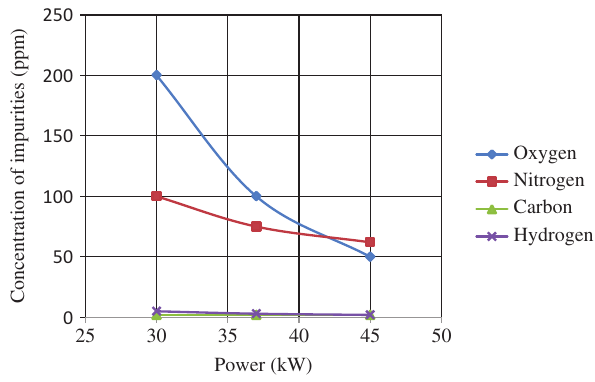
Figure 4: Effect of input power on concentrations of impurities in 60 mm diameter EB melted ingot produced at 2.5 kg/h melt